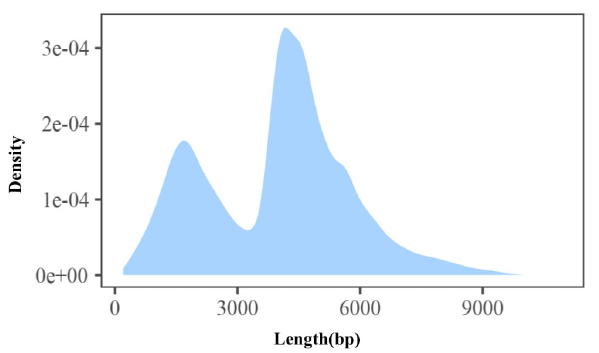
FIGURE 2 | Length distribution of full-length non-redundant transcript.